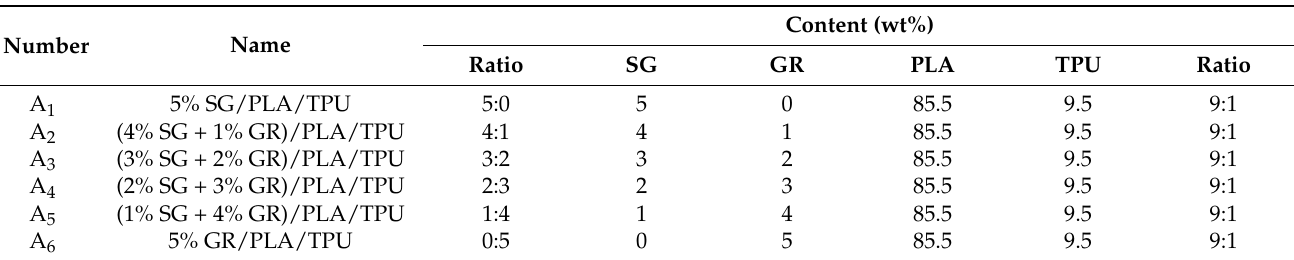
Table 4. Testing and characterization methods of material properties.